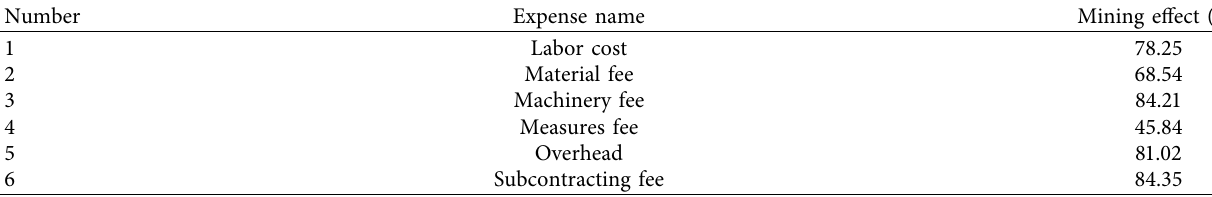
Table 1: Data mining effect of total project cost.